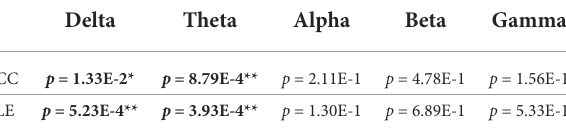
TABLE 2 Pearson correlation analysis results between global measures and decision accuracy in five bands.